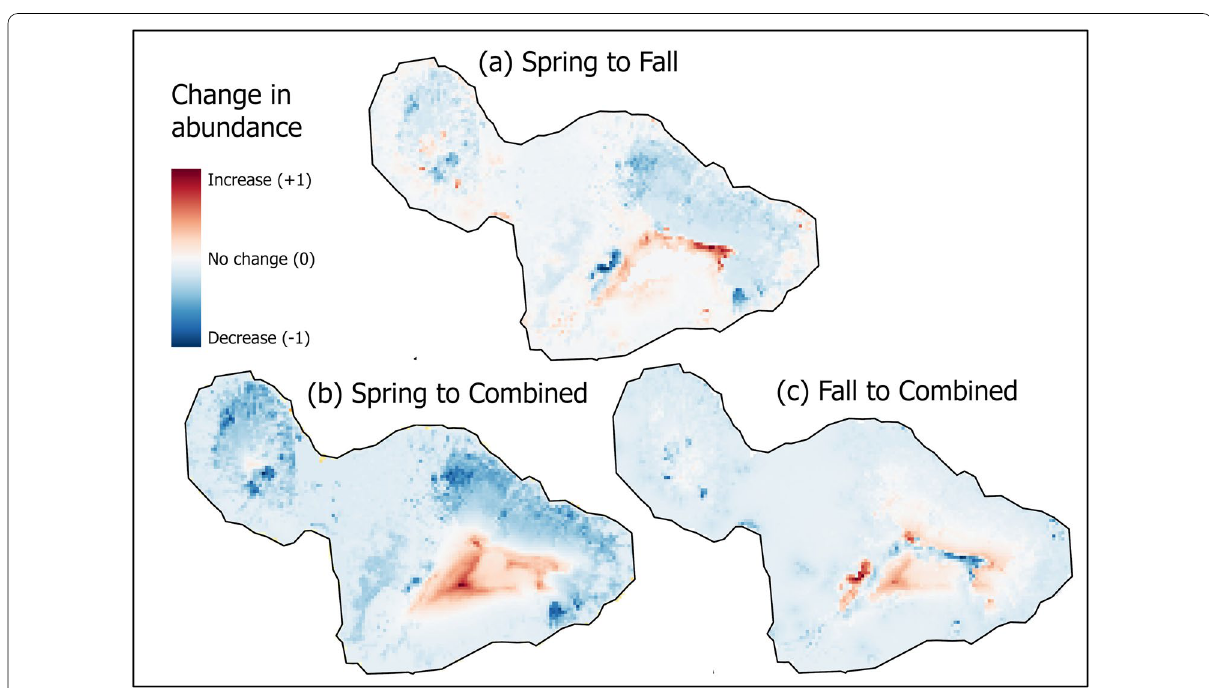
Fig. 3 Differences in relative abundance of wild pigs on Maui between the spring and fall model ( a ), spring and combined model ( b ), and fall and combined model ( c